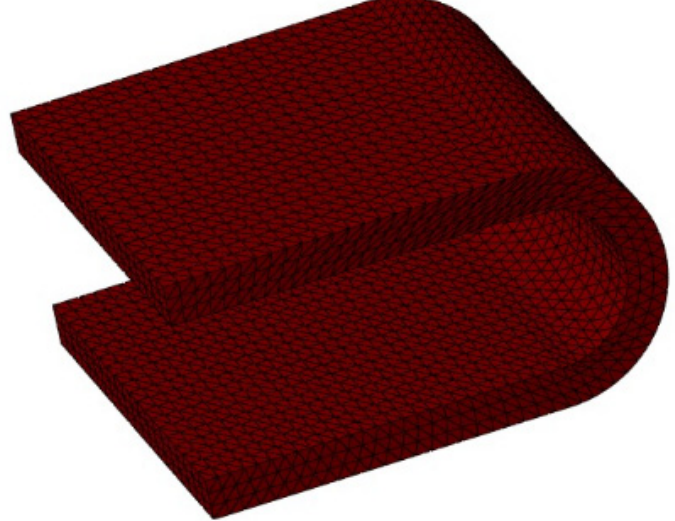
Figure 3. Dynamic cervical implant.